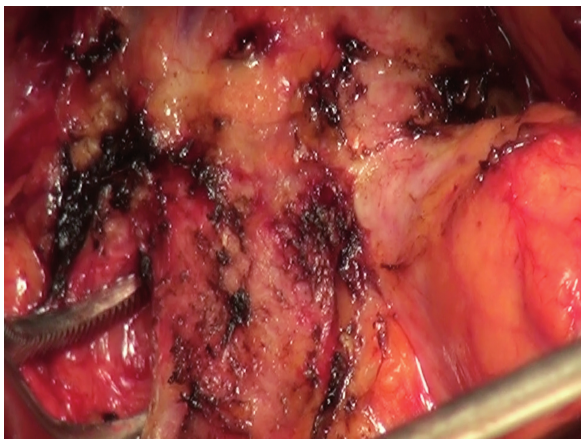
figure 1 - Lateral bladder neck dissection (radical retropubic prostatectomy).